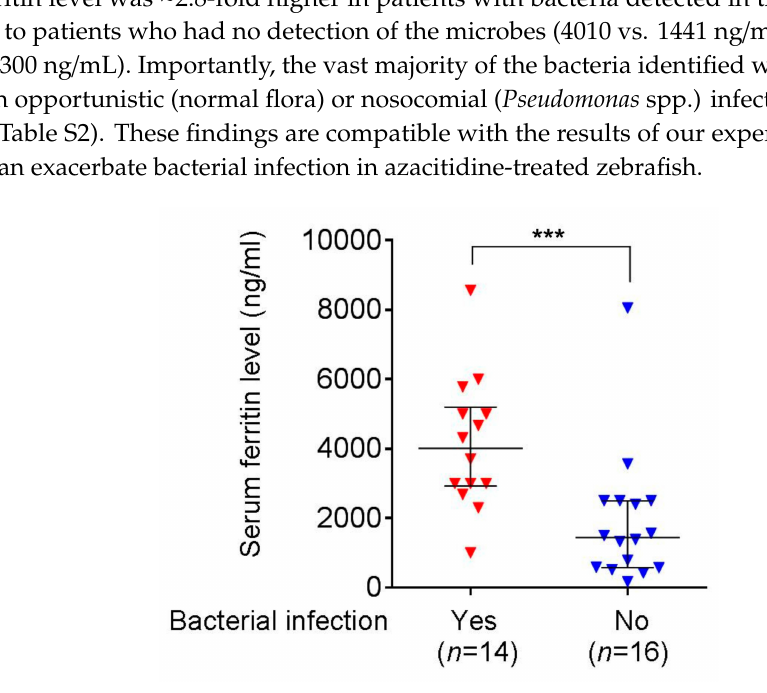
Figure 11. Serum ferritin levels in MDS patients with or without bacterial infection. Each symbol in the graph represents the data form each individual. The median and interquartile range are shown in lines. *** p < 0.001, by the Mann–Whitney U